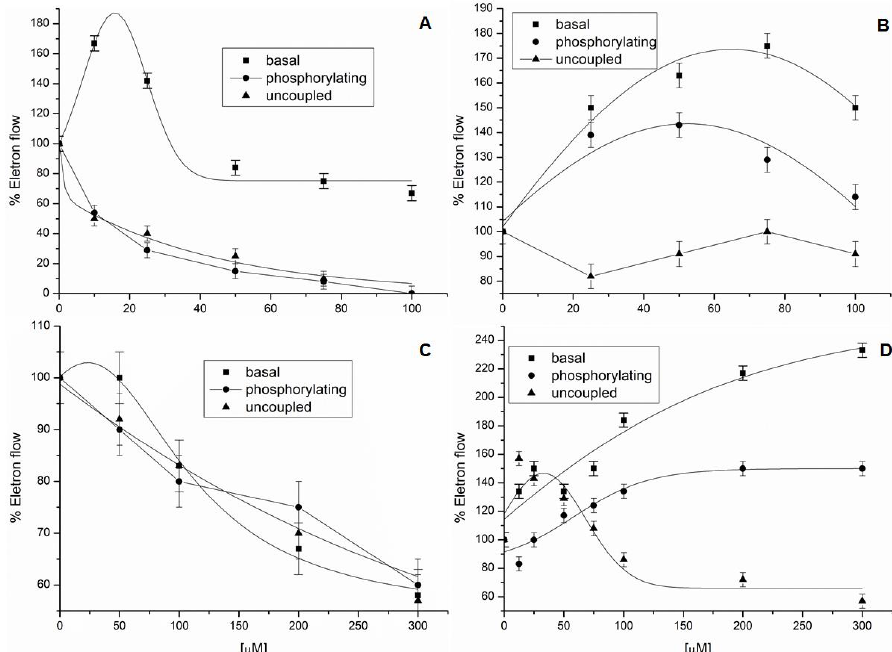
Figure 2. Effect of the alkaloids isolated from R. graveolens on electron flow. Control-rate values for electron transport from basal, phosphorylating, and uncoupled conditions were 450, 620, and 1200 µ equiv e − h − 1 mg − 1 chlorophyll (Chl) − 1 , respectively. Panel ( A ): Compound 1 ; Panel ( B ): Compound 4 ; Panel ( C ): Compound 5 ; and Panel ( D ): Mixtures 6 – 8 .